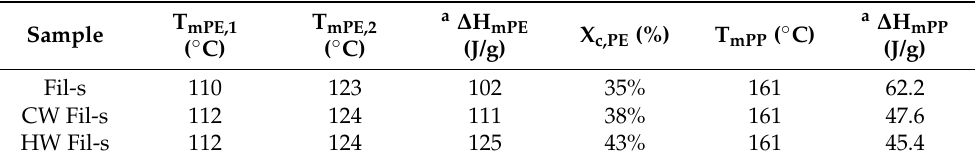
Table 3. Main thermal parameters, measured by the second heating scan, for the unwashed, Cold Washed and Hot Washed Fil-s samples.